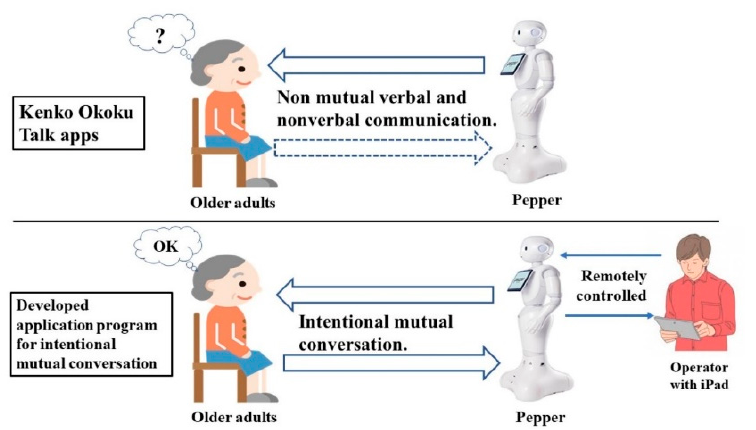
Figure 2. Difference between the Pepper conversation application ( Kenko Okoku Talk) and the application program developed for intentional mutual conversation.